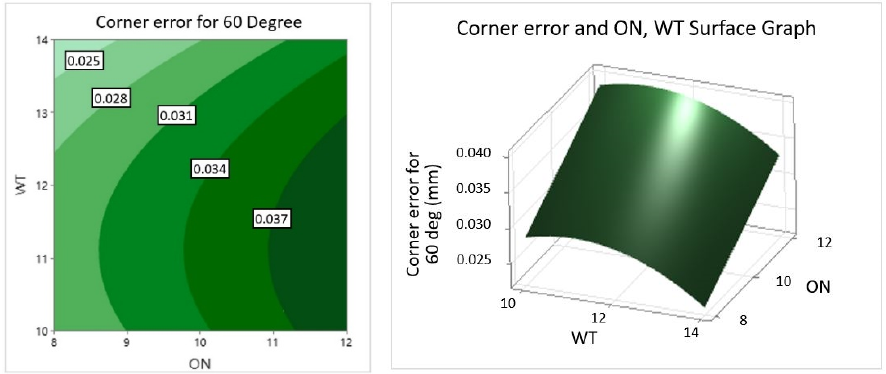
Figure 5. 2D contour and 3D surface plots corner error for 60° corner.